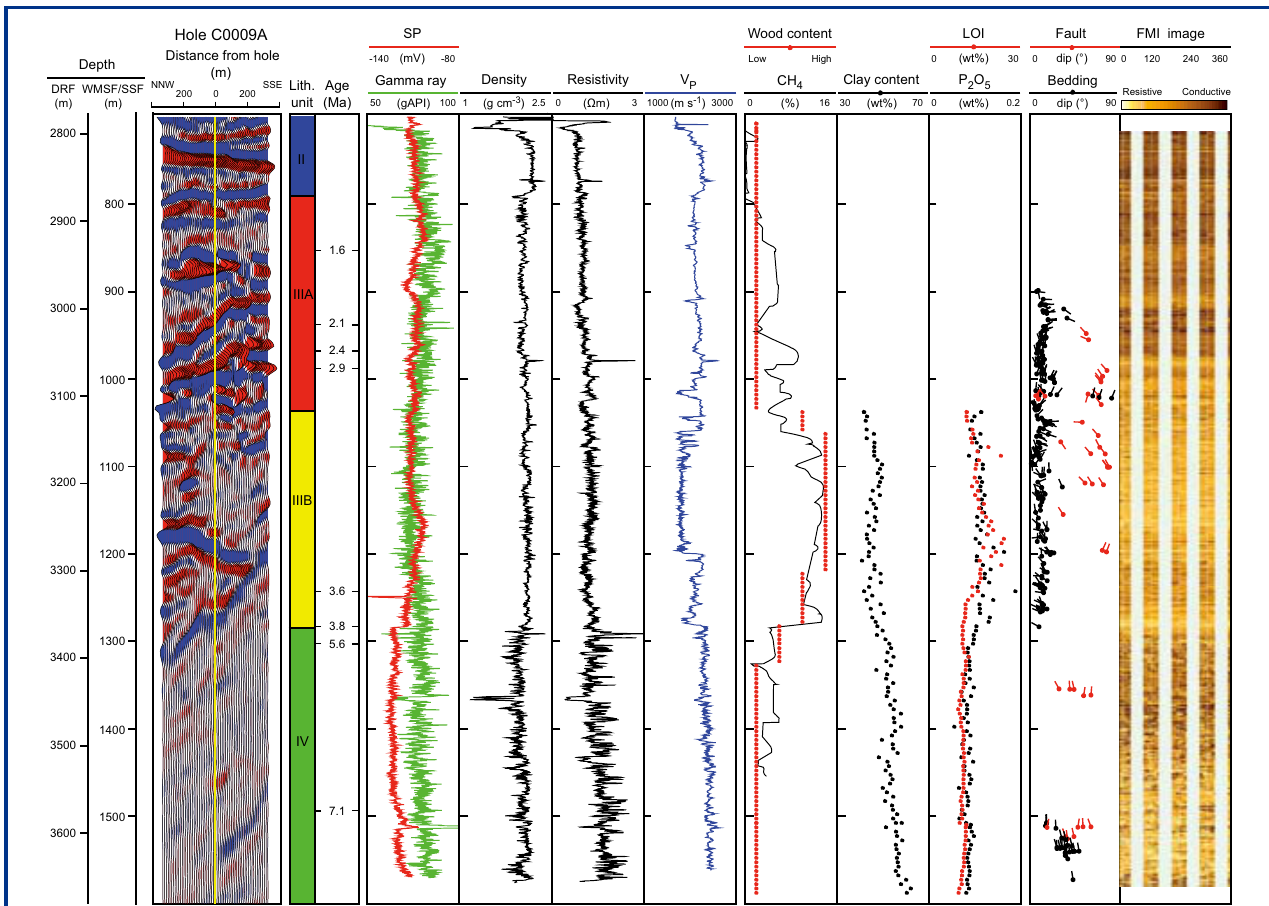
Figure 4. Site summary diagram for Site C0009 within the central forearc basin and hanging wall of the seismogenic plate boundary fault, showing wireline logs and cuttings data from ~700 mbsf to 1600 mbsf. SP=spontaneous potential, LOI=loss on ignition, FMI=Formation MicroImager (resistivity